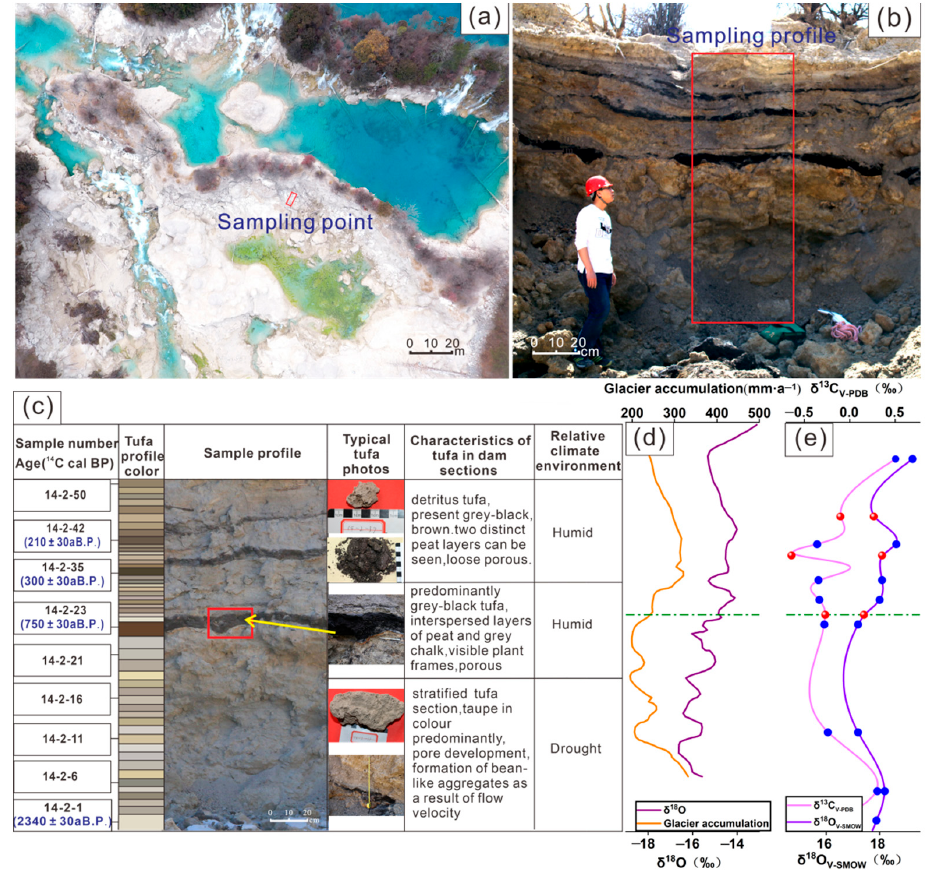
Figure 2. Collected calcareous tufa deposition profile at the Sparkling Lake. ( a ) The lake dried up after the earthquake. The red frame shows the sampling location. ( b ) Sparkling Lake calcareous tufa sampling profile. ( c ) Calcareous tufa characteristics and dating data. ( d ) Changes in 18 O and glacier accumulation recorded by Guliya ice cores over the last millennium (data from Yao et al. [40]). ( e ) Carbon-oxygen isotope analysis of the calcareous tufa profile. The blue dots represent experimentally measured carbon-oxygen isotope data. The red dots represent the location of the black peat layer.